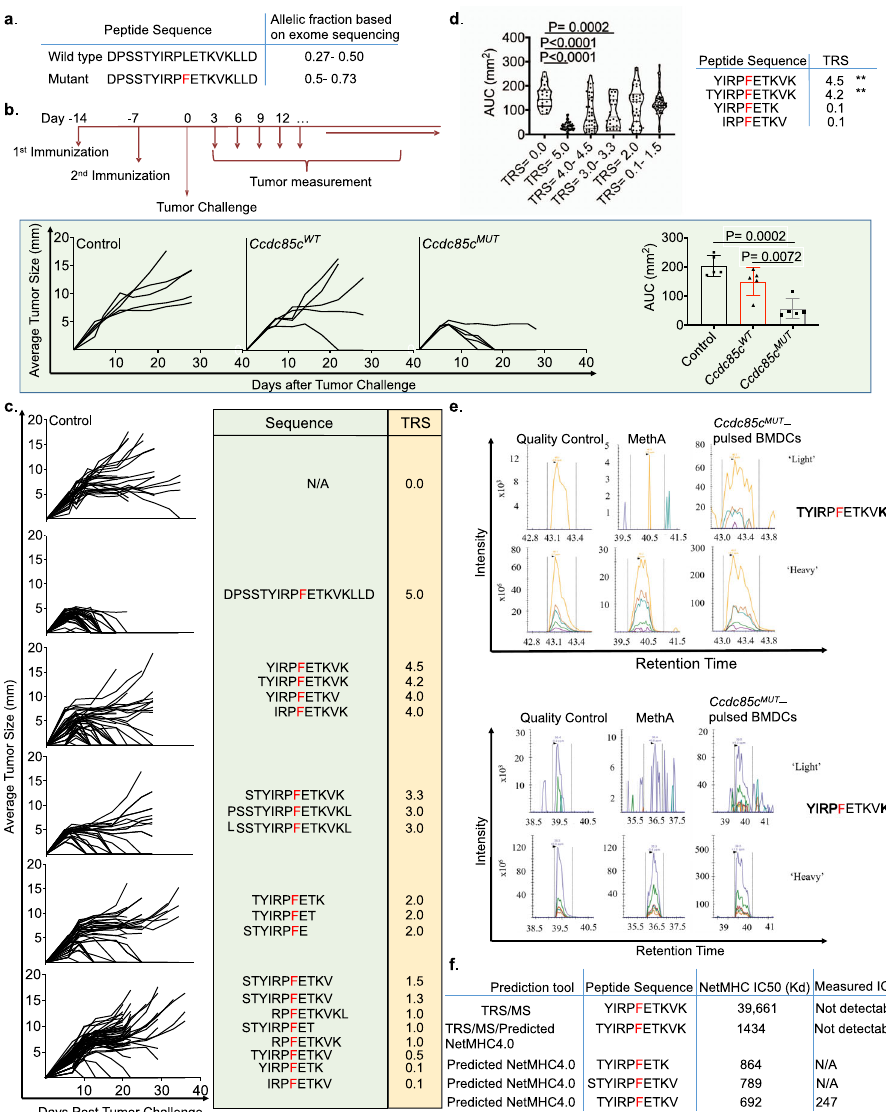
Fig. 1 De fi nition of the precise neoepitope of Ccdc85c MUT that mediates tumor rejection. a The sequences of the 18-mer wild type and mutant peptides derived from Ccdc85c gene as well as their corresponding allelic fractions (the number of mutant/normal reads divided by the total number of reads (coverage) at a speci fi c genomic position) are shown. b The top panel shows a schematic diagram of immunization and tumor challenge in BALB/cJ mice. The bottom panel (left) shows tumor growth in BALB/cJ mice immunized with Ccdc85c MUT or Ccdc85c WT and challenged with Meth A as described in Methods. Each line represents tumor growth in a single mouse ( n = 5 mice per group). AUC for each group is plotted in the panel on the right. Data are presented as mean ± SD. P values were calculated using 1-way ANOVA test adjusted for multiple comparisons (Tukey ’ s multiple comparison test). c Several truncated versions of the 18-mer Ccdc85c MUT peptide were tested in tumor rejection assay. BALB/cJ mice were immunized and tumor challenged. Each line represents tumor growth in a single mouse. Although mice were immunized with individual peptides, the data for multiple peptides are grouped into one with the composition of the peptides shown on the right. The tumor rejection data for individual peptides are shown in Supplementary Fig. 1. Tumor rejection score (TRS) for each neoepitope is shown in the yellow box, where fi ve represents a complete tumor protection and zero means no tumor rejection. d On the left panel, total Area Under the Curve (AUC) scores for each group in B are plotted. Each bar shows the average total AUC score for the indicated group (TRS = 5; n = 35, TRS = 4 – 4.5; n = 40, TRS = 3 – 3.3; n = 25, TRS = 2; n = 30, TRS = 0.1 – 1.5; n = 60). Error bars represent standard deviation (SD). The P values corresponding to the comparison of TRS = 0 with TRSs 5.0, 4.0 – 4.5 and 3.0 – 3.3 were respectively <0.0001, <0.0001 and 0.0002. P values were calculated using 1-way ANOVA test adjusted for multiple comparisons. On the right, peptides with the highest and the lowest TRS are shown. e Targeted MS-based detection of TYIRPFETKVK and YIRPFETKVK among MHC I peptides eluted from BMDCs pulsed with the 18-mer Ccdc85c MUT . Heavy labeled synthetic peptides were spiked into the peptide samples; the labeled amino acid is marked with a bold character and the mutation is in red. Matched peak lists for the “ heavy ” and “ light ” ions were extracted and monitored, while only single charge y ions were plotted. See Methods for details. f Predicted (by NetMHC4.0) and measured IC50 values of the binding of candidate precise neoepitopes of Ccdc85c MUT to K d are shown. The candidate neoepitopes include those de fi ned by tumor rejection and MS as in panels c and e . The other three candidate neoepitopes were predicted by NetMHC4.0 alone and were not active in tumor rejection. The af fi nities of the MS/TRS predicted neoepitopes were also measured for D d and L d ; measured af fi nities were below the level of